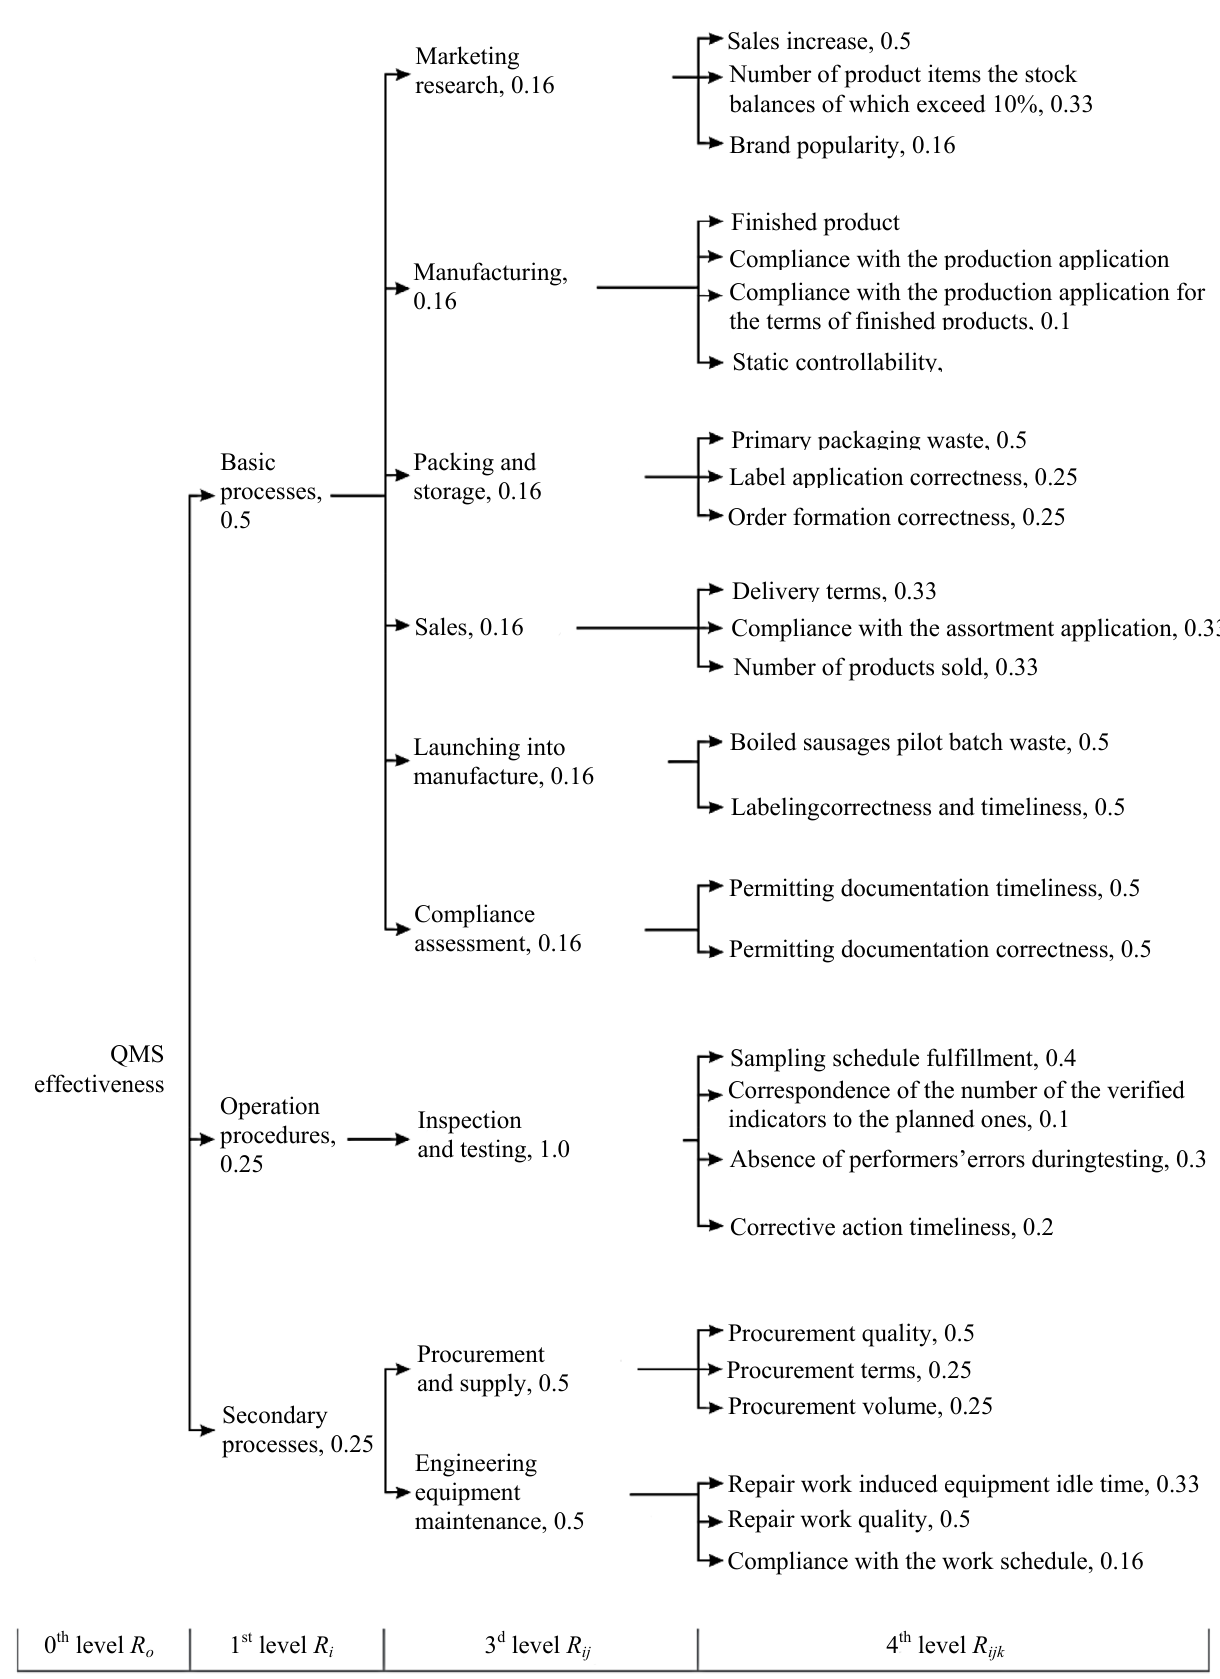
Fig. 4. Treelike diagram of the performance indicators of quality management system